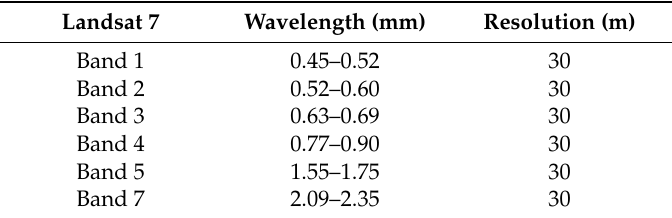
Table 1. Band designations of bands 1–5 and 7 of Landsat Enhanced Thematic Mapper Plus (ETM+) images.